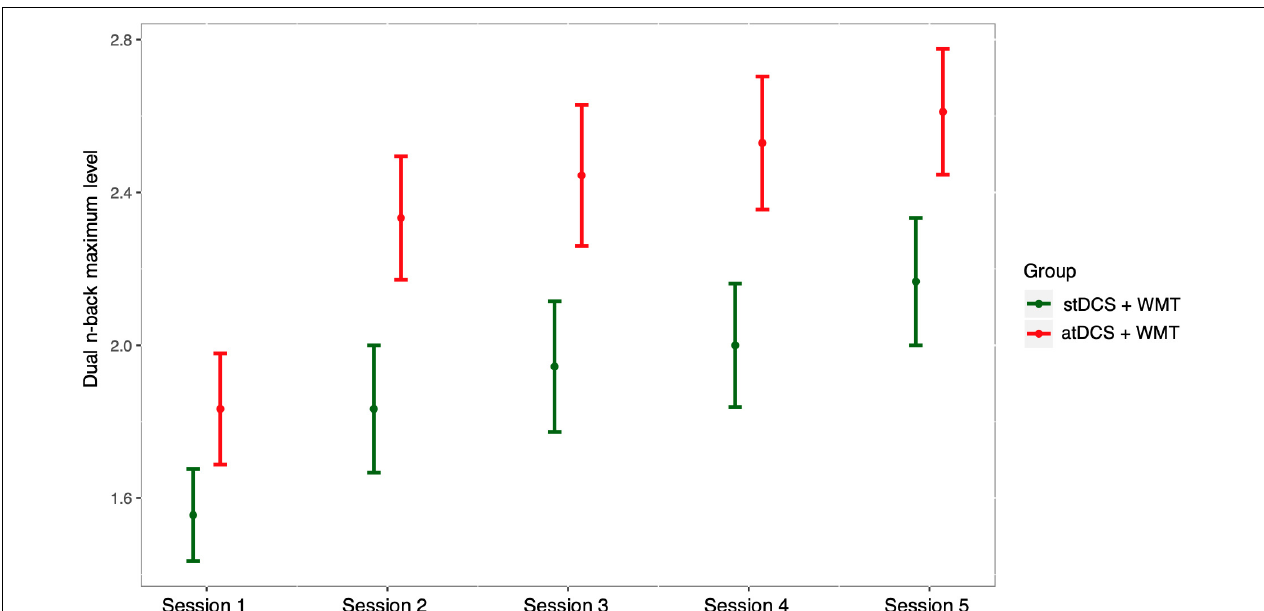
FIGURE 2 | Dual n -back maximum level. The horizontal axis represents the five training sessions while the vertical axis represents the raw data with the maximum level participants achieved in the dual n -back task in that